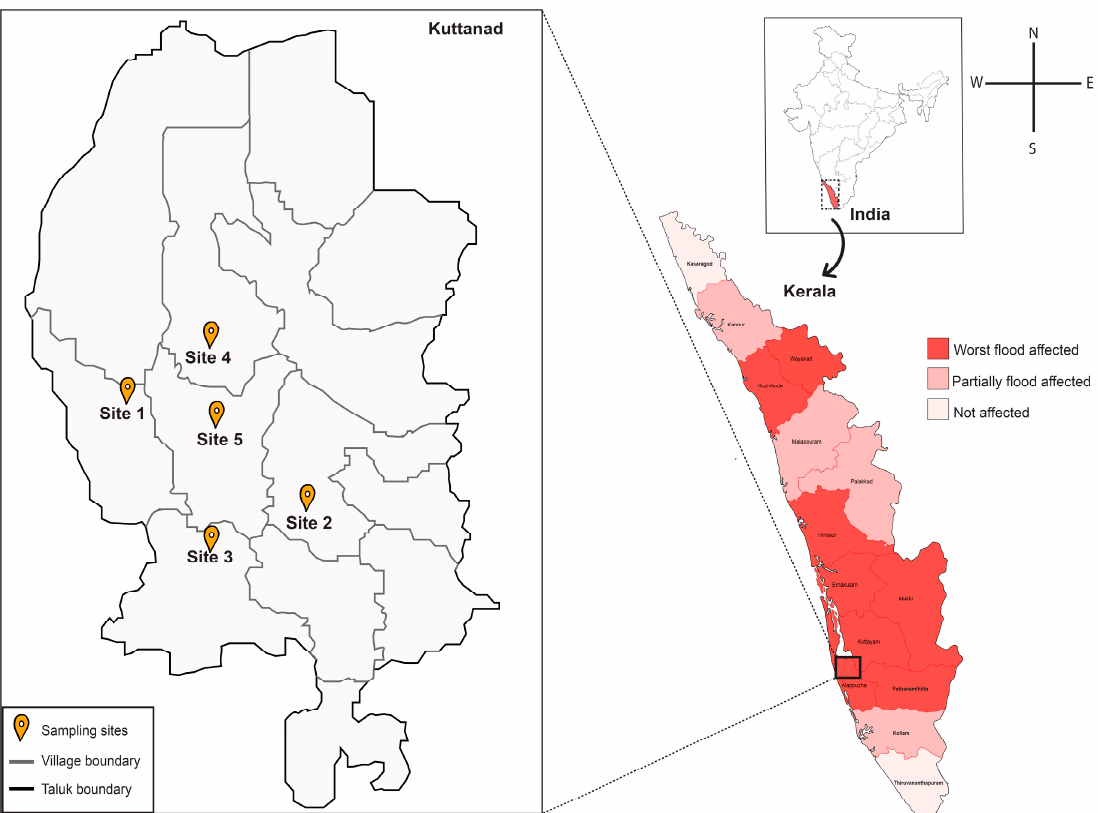
Figure 4. Map showing flooded regions and sampling sites of state Kerala, India. The intensity of the red colour indicates the level of flood severity in fourteen districts of Kerala during August 2018. Triplicate samples were collected from each site during August 2018.